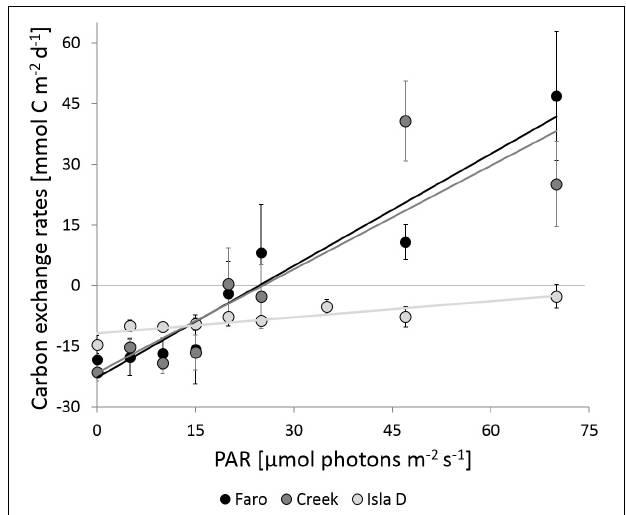
FIGURE 3 | Carbon exchange rates at different PAR intensities. Negative exchanges rates are net respiration and positive exchange rates net primary production of the benthic community. The linear regression for Faro, Creek, and Isla D was y = 0.9221 x – 22.72 ( R 2 = 0.925), y = 0.8536 x – 21.59 ( R 2 = 0.781), and y = 0.1327 x – 11.83 ( R 2 = 0.779), respectively.